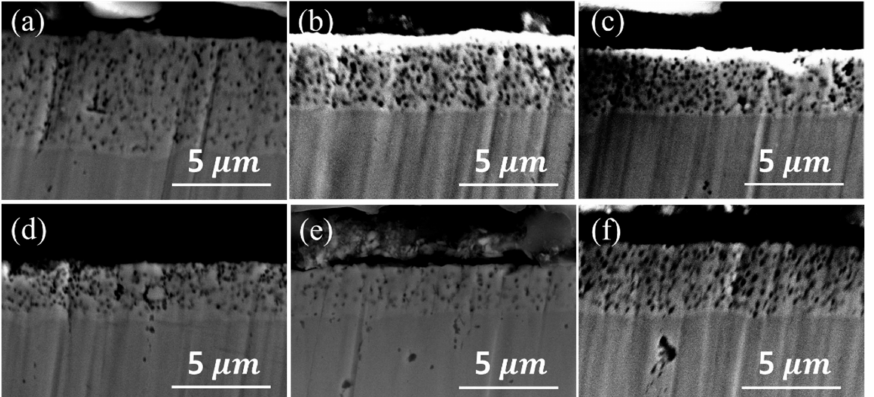
Figure 4. Plating thicknesses for various PTFE concentrations and methods: conventional process; ( a ) 1 g/L, 5.68 µ m, ( b ) 3 g/L, 3.45 µ m, ( c ) 5 g/L, 3.11 µ m, ( d ) 7 g/L, 2.66 µ m, ( e ) 9 g/L, 2.13 µ m, two-step process; ( f ) 3 g/L, 3.44 µ